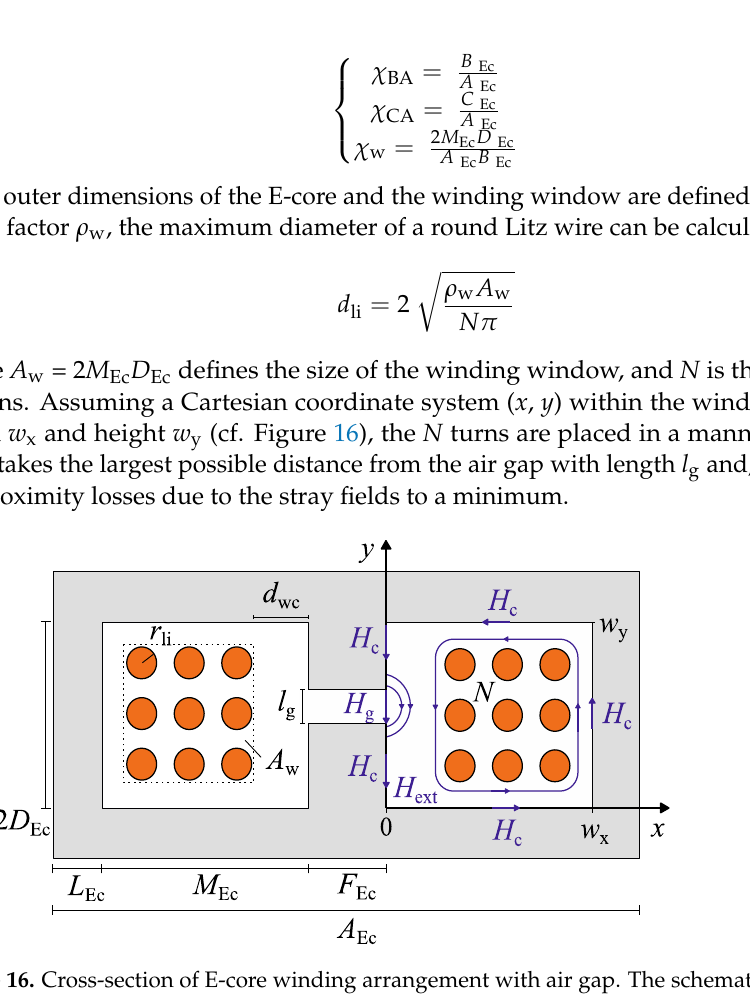
Figure 16. Cross-section of E-core winding arrangement with air gap. The schematic representation is assumed to be infinitely in z-direction.